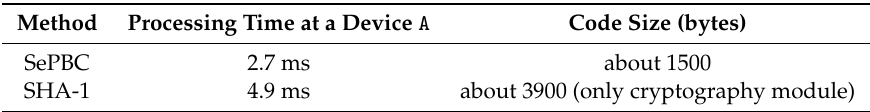
Table 4. Summary of the overheads of SePBC compared to the SHA-1-based algorithm for the ATmega128